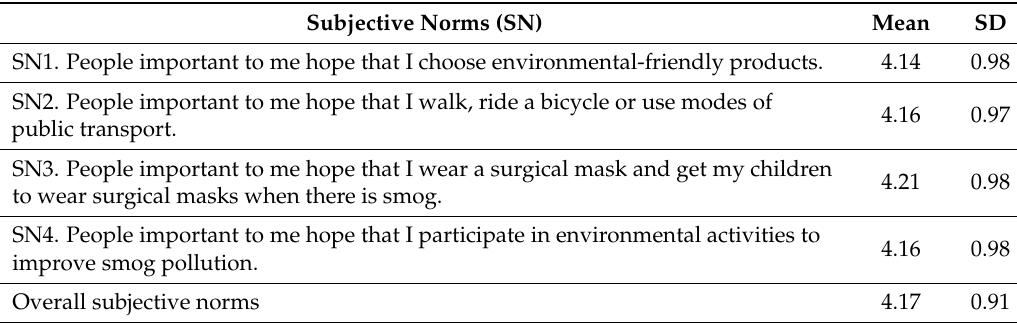
Table 7. Descriptive statistics for subjective norm (SN)-related